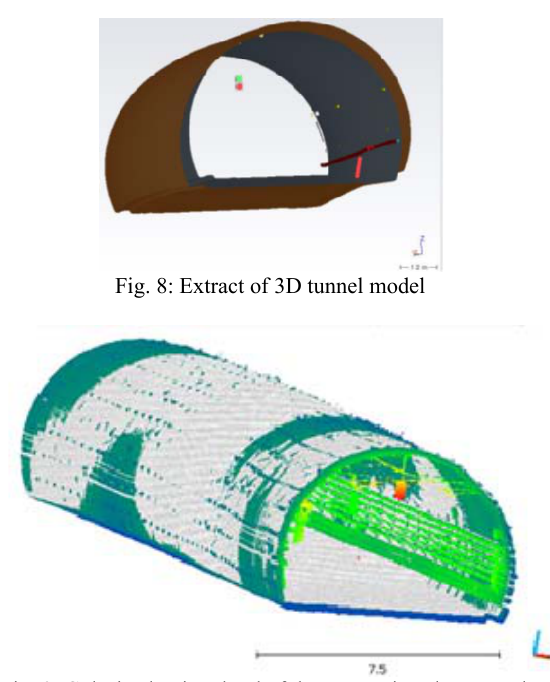
Fig. 9: Colorized point cloud of the comparison between the modeled wall and the point cloud